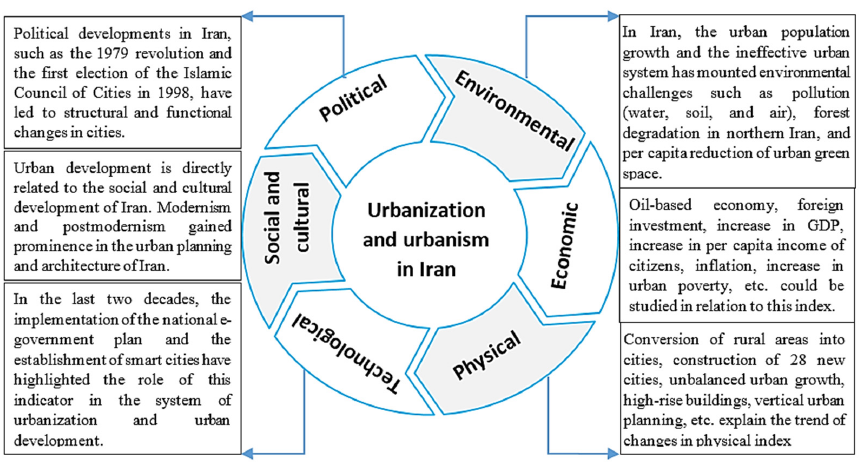
Figure 11. Indicators affecting the rapid growth and development of urbanization in Iran.